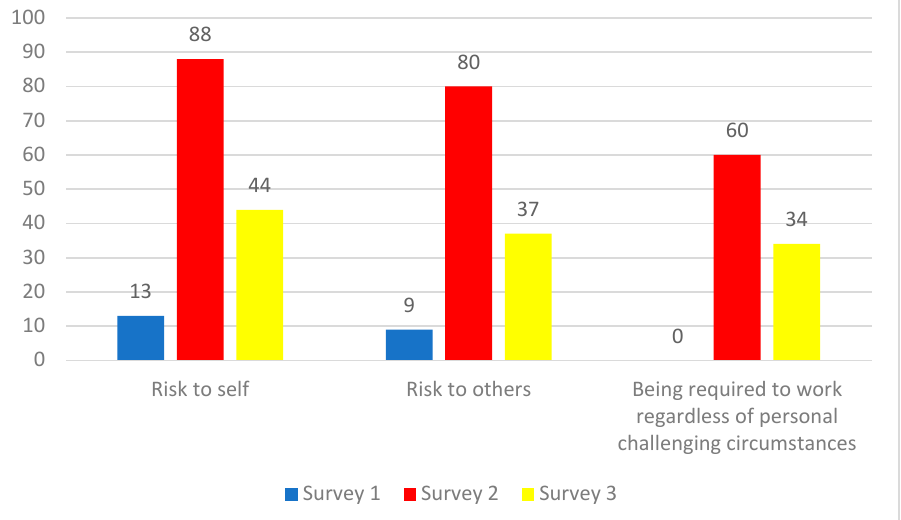
Figure 4. Number of responses corresponding to theme 2: Risks of COVID-19 infection and transmission. Since participants could select multiple themes, it is not possible to calculate percentages.